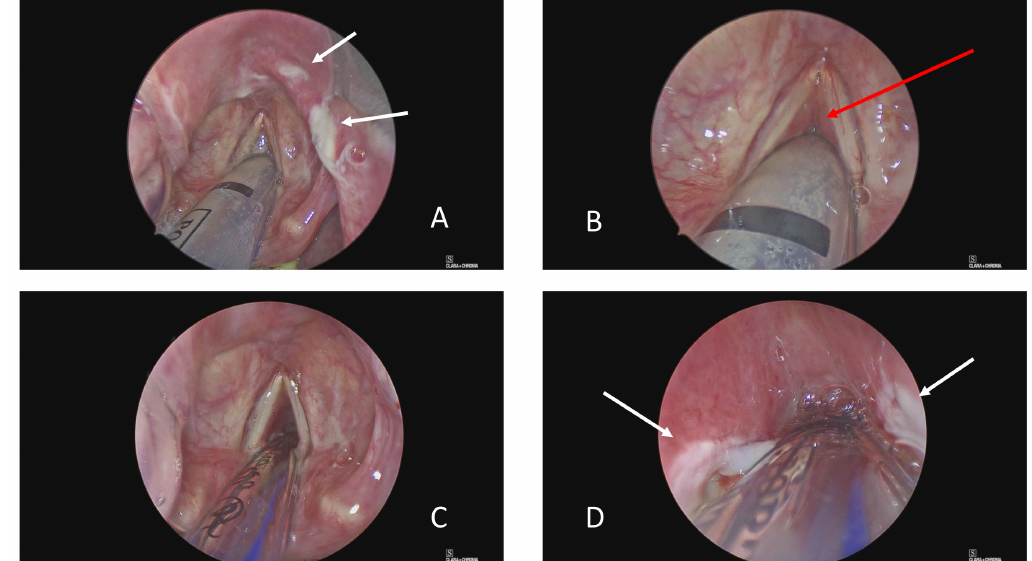
Figure 2. Case 1 glottis images. ( A ) View of supraglottis showing ulcerated epiglottis. ( B ) Glottis showing relative sparing of vocal cords and false cords, but profound subglottic oedema. ( C ) Following change to size 6 endotracheal tube, there is some anterior glottic